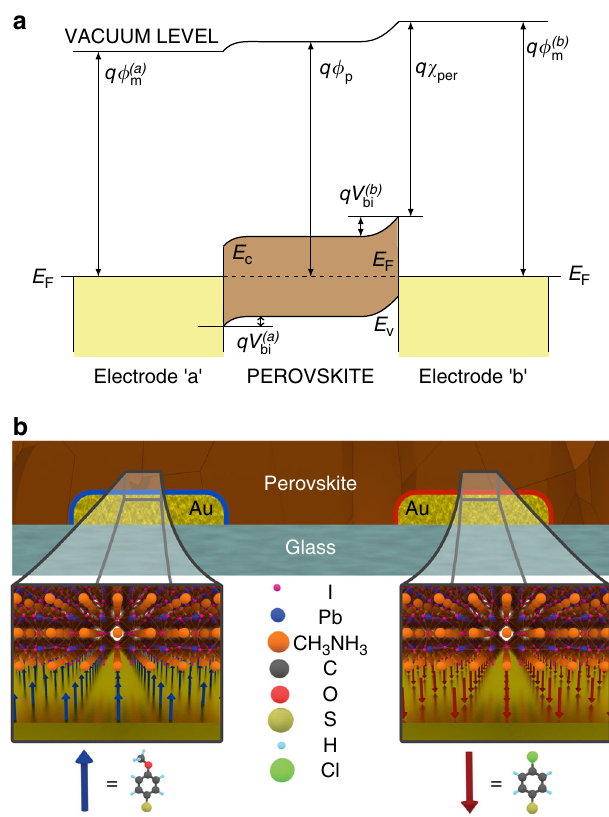
Fig. 2 Back-contact metal-perovskite-metal solar cells. a Schematic energy band diagram of a metal-perovskite-metal solar cell at thermal equilibrium in the dark. The work function of the methylammonium lead iodide (MAPbI 3 ) perovskite ( q ϕ ) is situated between those of the metal p electrodes “ a ” ( q ϕ ð a Þ ) and “ b ” ( q ϕ ð b Þ ). The overall built-in potential of the m m solar cell is equal to the sum of the built-in potentials at the metal- perovskite contacts. q χ corresponds to the electron af fi nity of MAPbI 3 . per b Cross-section diagram of a dipole self-assembled monolayer (SAM) modi fi ed back-contact gold-perovskite-gold solar cell. Electrode “ a ” (anode, left) is modi fi ed with a molecular monolayer of 4-methoxythiophenol (OMeTP) with a molecular dipole of − 2.67D. Electrode “ b ” (cathode, right) is modi fi ed with a monolayer of 4-chlorothiophenol (ClTP) with a molecular dipole of + 1.41 (PESA) measurements on SAM-modi fi ed gold fi lms (Supplemen-